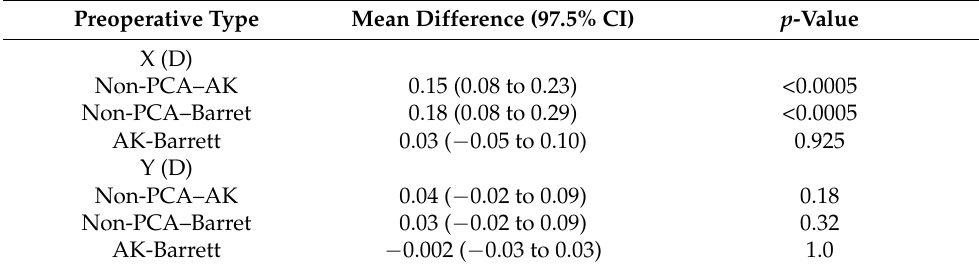
Table 2. Pairwise comparisons with Bonferroni correction.